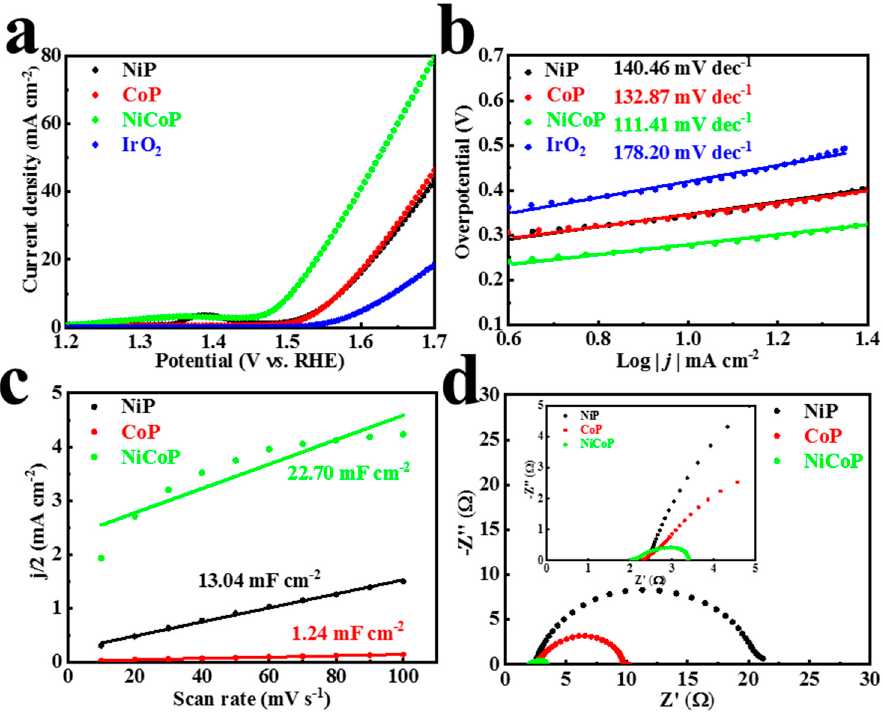
Figure 6. ( a ) LSV curves and ( b ) Tafel plots of NiP, CoP, NiCoP 1 h, and IrO 2 . ( c ) The double − layer capacitance (C dl ) and ( d ) EIS Nyquist plot of NiP, CoP, and NiCoP 1 h in 1 M KOH for OER; the inset presents the plot enlarged over the high frequency range.